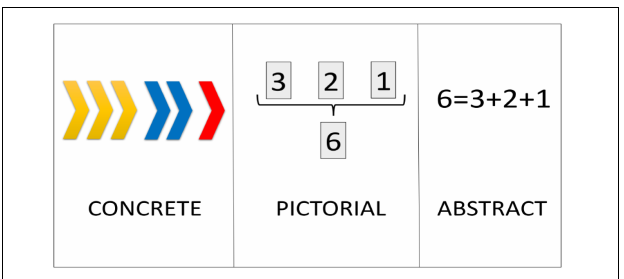
FIGURE 6 | Example of application of the Concrete Pictorial Abstract